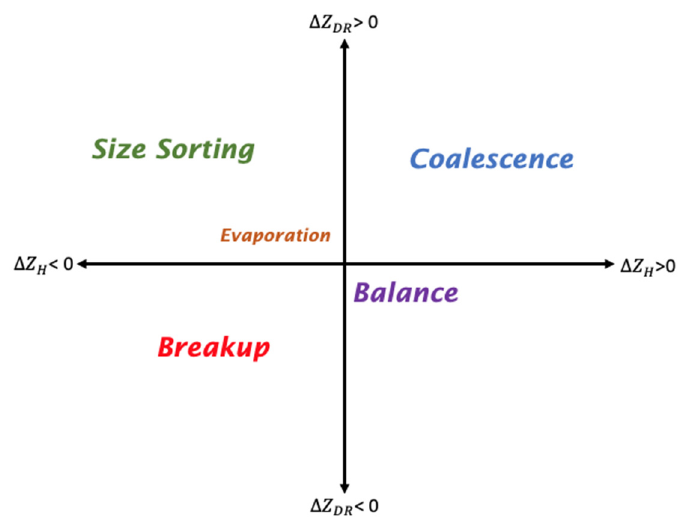
Figure 4. Fingerprint parameter space of [44]; shows dominant processes (colored text in each quadrant) inferred from vertical gradients in Z H and Z DR ( ∆ , with changes towards ground). For example, coalescence is inferred from vertical profiles of Z H and Z DR that increase towards the ground (i.e., ∆ Z H > 0 dB and ∆ Z DR > 0 dB).